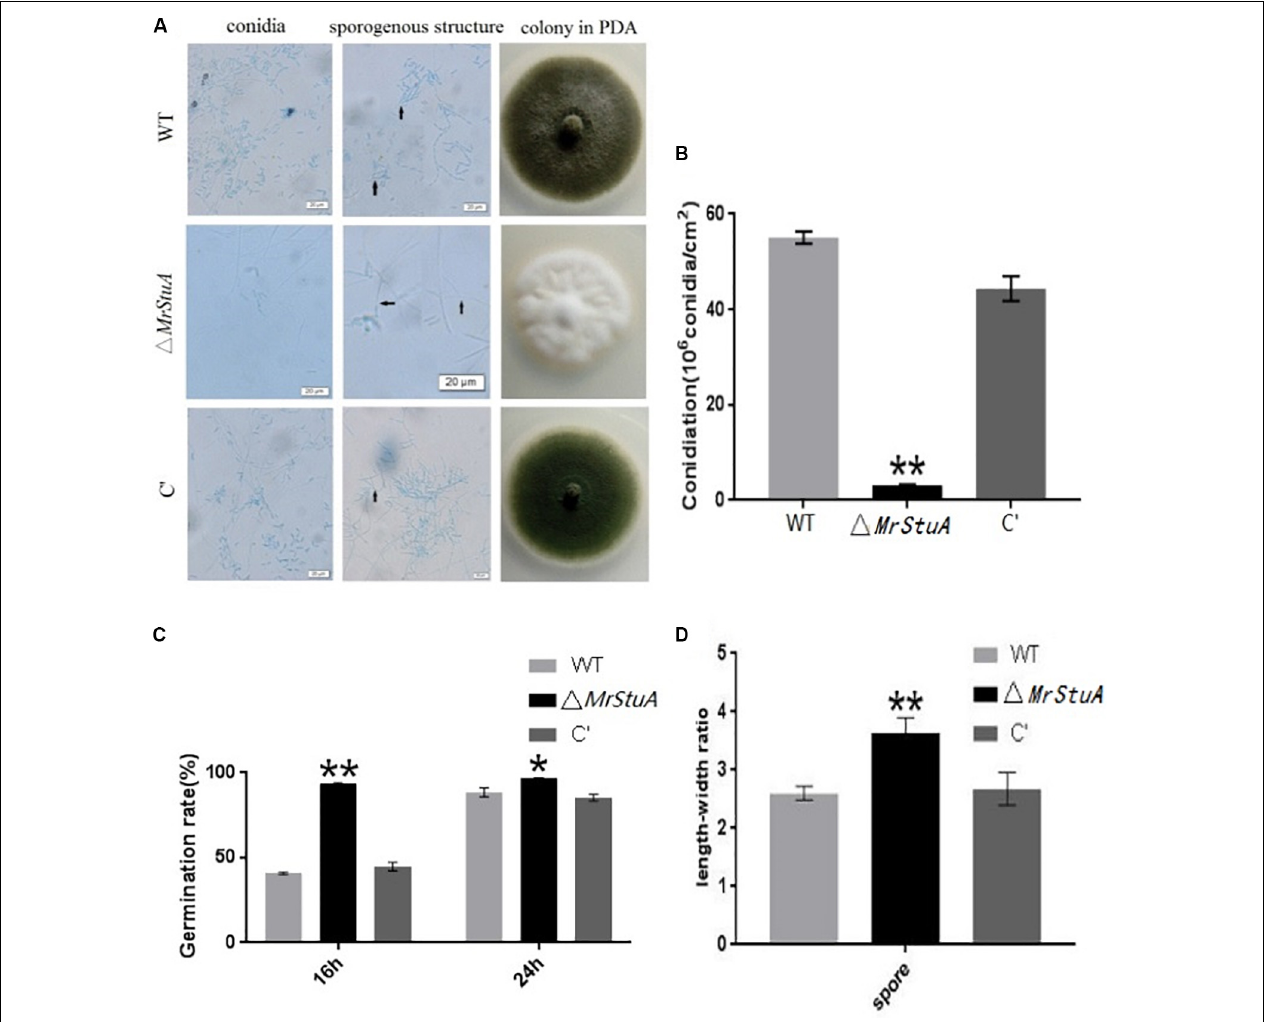
FIGURE 2 | Changes in conidia capacity, conidium shape, conidiophore structure, and germination time between the wild type and mutant strains. (A) Morphology of the conidia, hypha and conidiophore structures, and colonies for the WT, (cid:77) MrStuA , and C’ strains. (B) Conidia numbers per growth area (cm 2 ) for the WT, (cid:77) MrStuA , and C’ strains. (C) Germination rate of conidia for the WT, (cid:77) MrStuA , and C’ strains. (D) The aspect ratio of the conidia for the WT, (cid:77) MrStuA , and C’ strains. Student’s t -test: ∗ p < 0.05, ∗∗ p < 0.01.